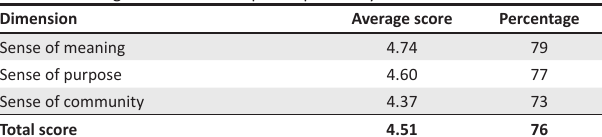
TABLE 2: Average scores for workplace spirituality